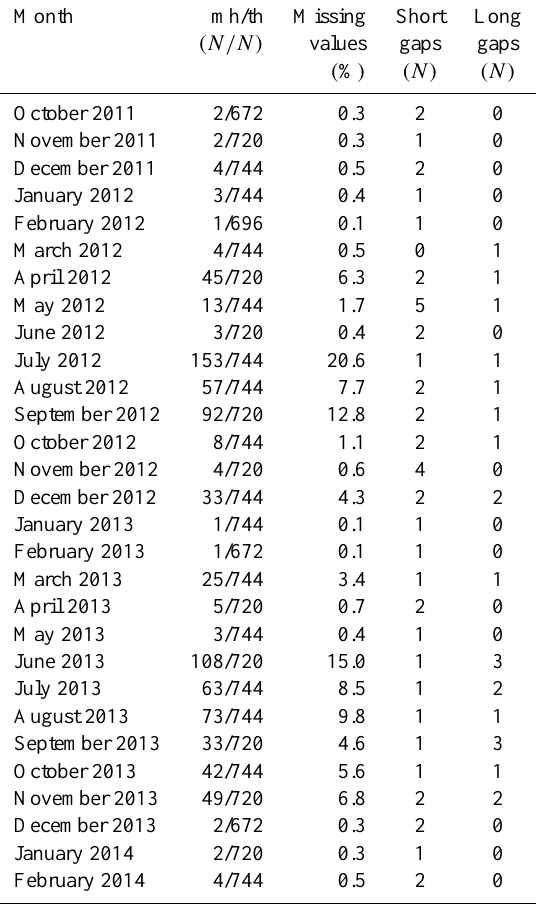
Table 1. Total number ( N ) of missing hourly average ambient data (mh), total number of hours per month (th), percentage (%) of missing hourly average ambient data for each month and number of short ( ≤ 3h) and long ( > 3h) data